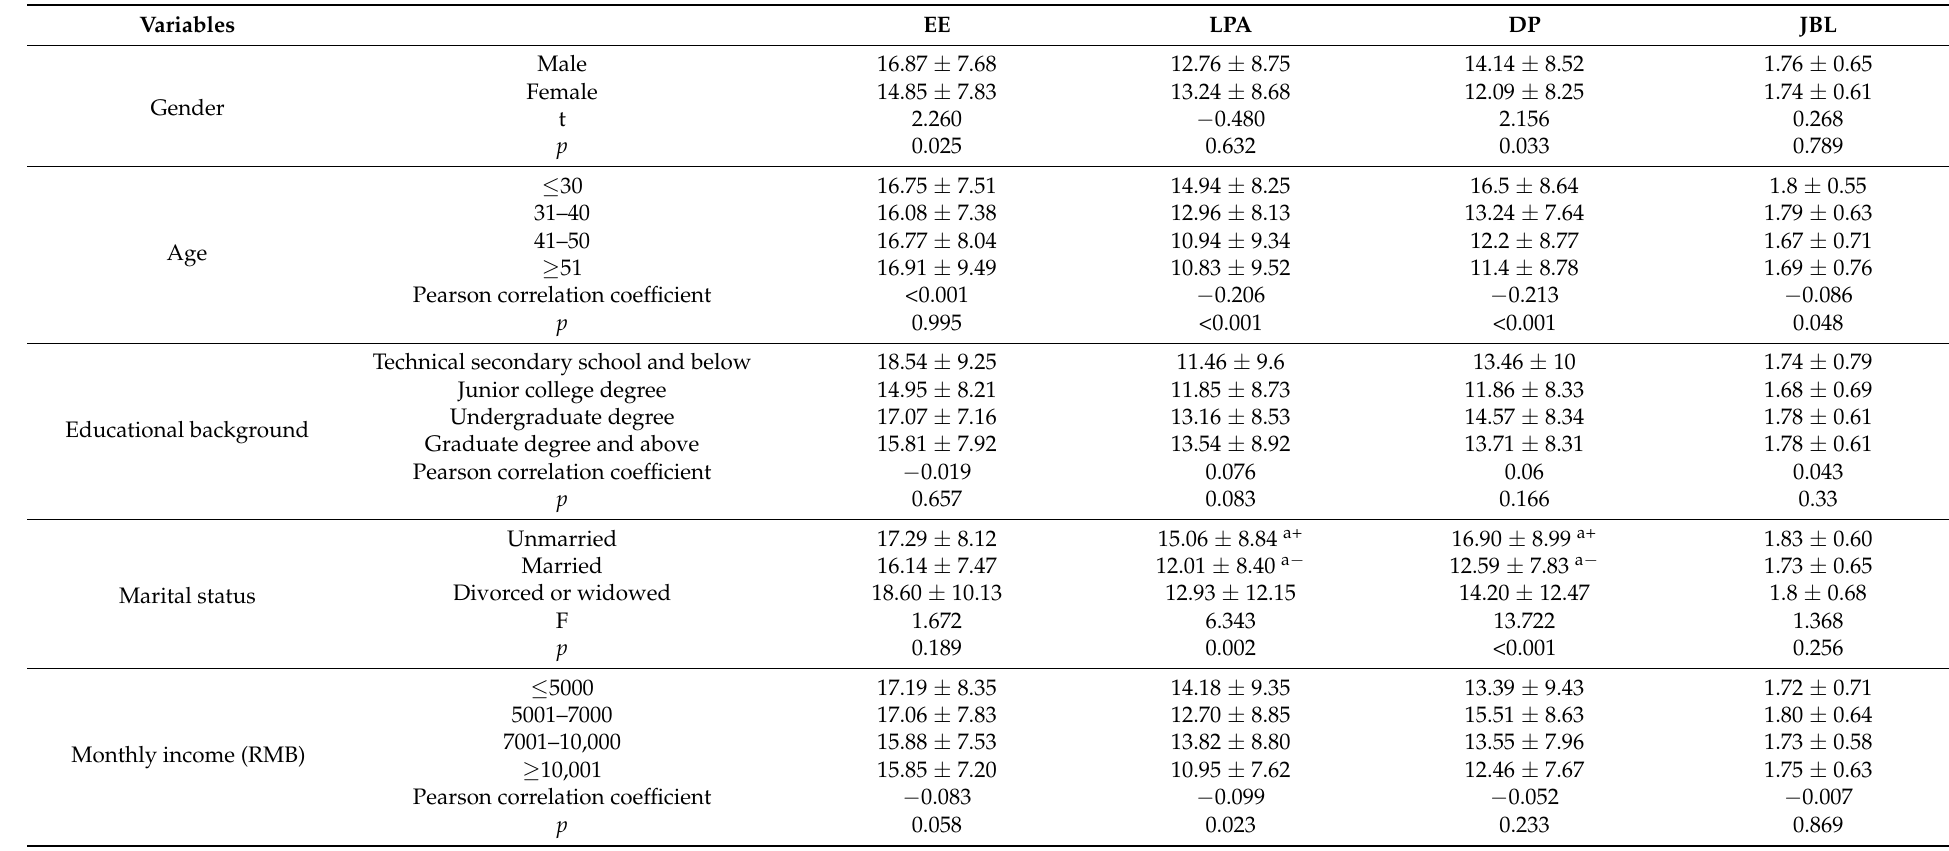
Table 3. Mean scores of MBI-GS and its subscales according to individual factors and work-related factors (M ±